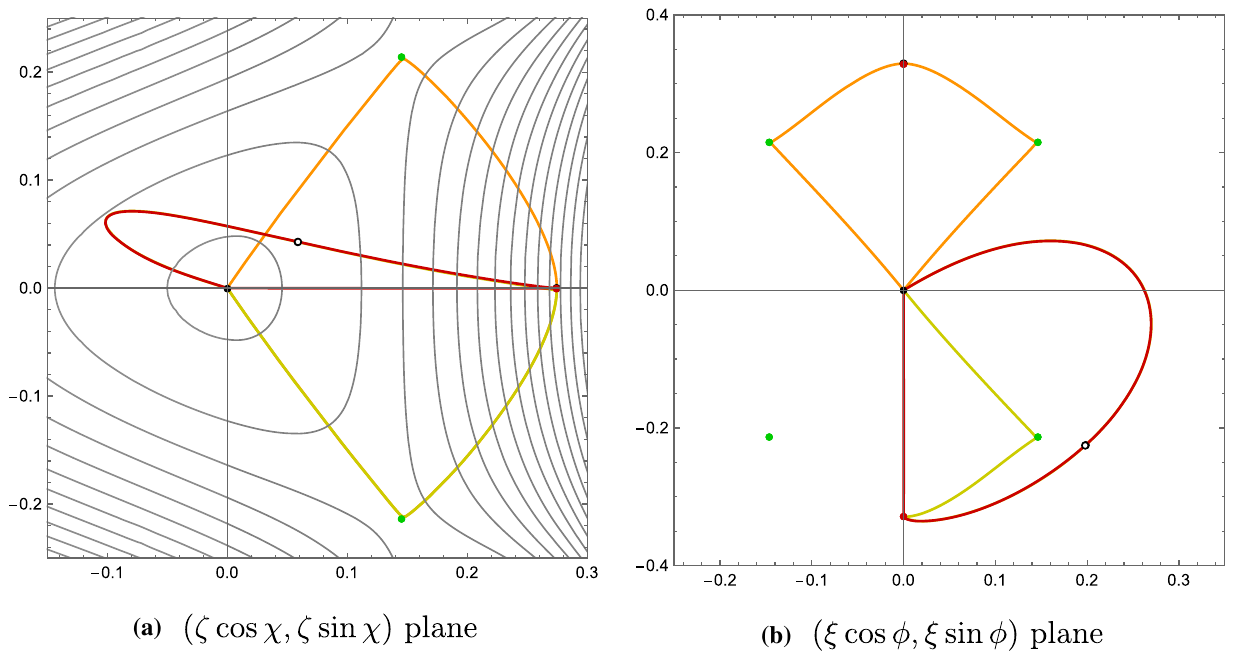
Fig. 7 An SO ( 8 )/ U ( 3 ) Janus solution is shown on the contour plot of the superpotential by the red line. The yellow and orange lines represent SO ( 8 )/ G 2 and G 2 / G 2 solutions that flow to the U ( 3 ) critical